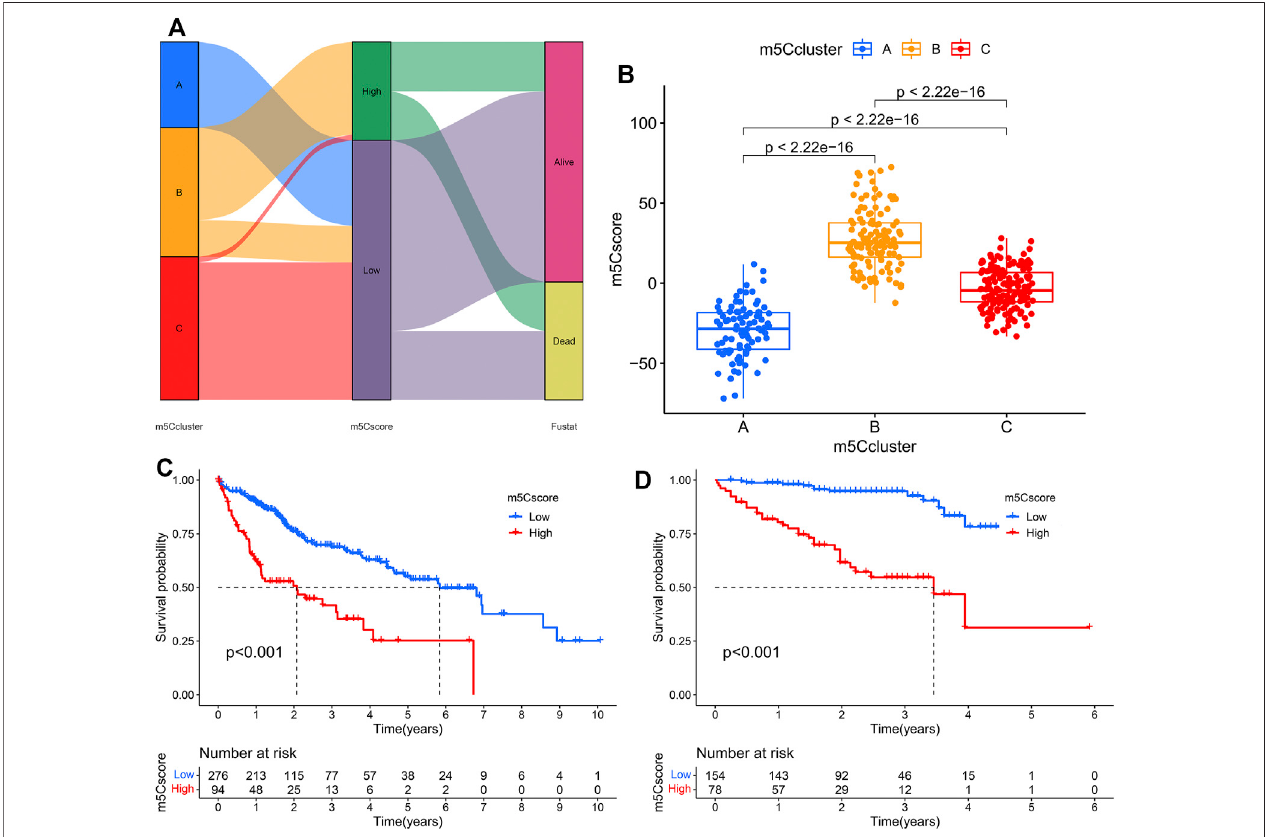
FIGURE 6 | Construction of the m5Cscore model. (A) Alluvial diagram showing the changes in m5Cclusters and m5Cscore; (B) Differences in m5Cscore among the three m5Cclusters; (C) KM analysis of patients in the high- and low-m5Cscore groups (TCGA cohort); (D) KM analysis of patients in the high- and low-m5Cscore groups (ICGC